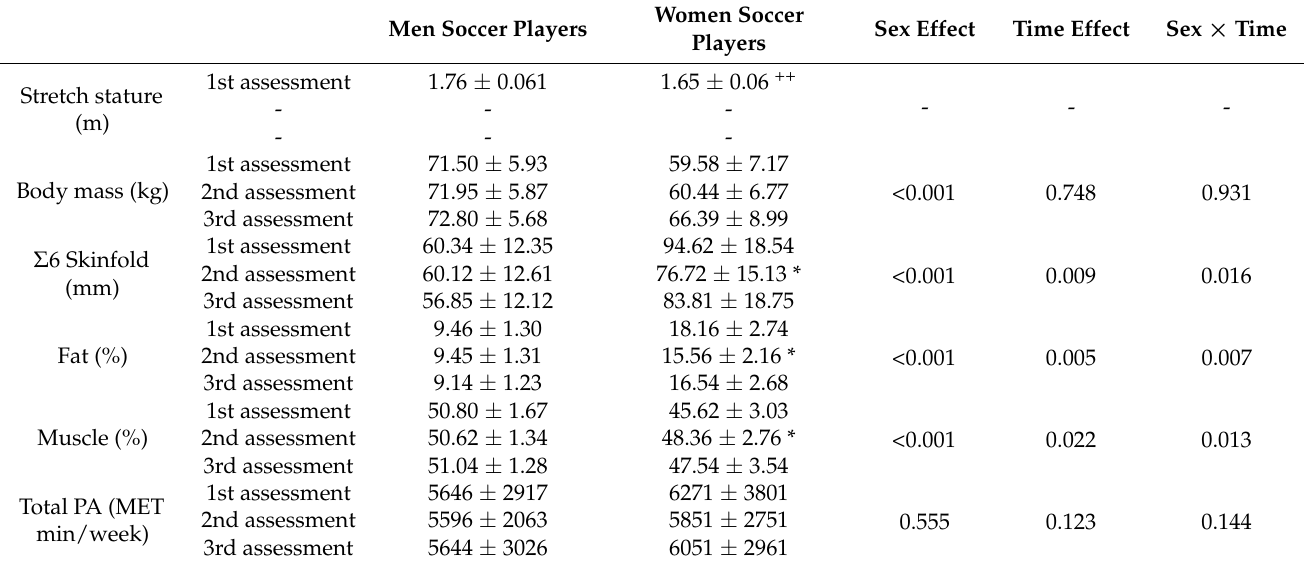
Table 4. Anthropometric characteristics, body composition and physical activity of the participants. Men Soccer